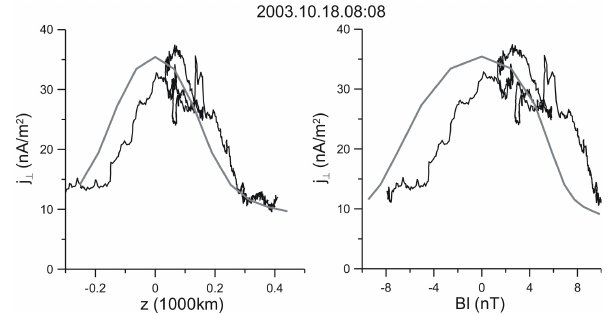
Fig. 7. Comparison of experimental (black) and model (grey) cur- rent density profiles w.r.t. coordinate along the normal and magnetic field component B l . Case 18 October 2003 (#16).